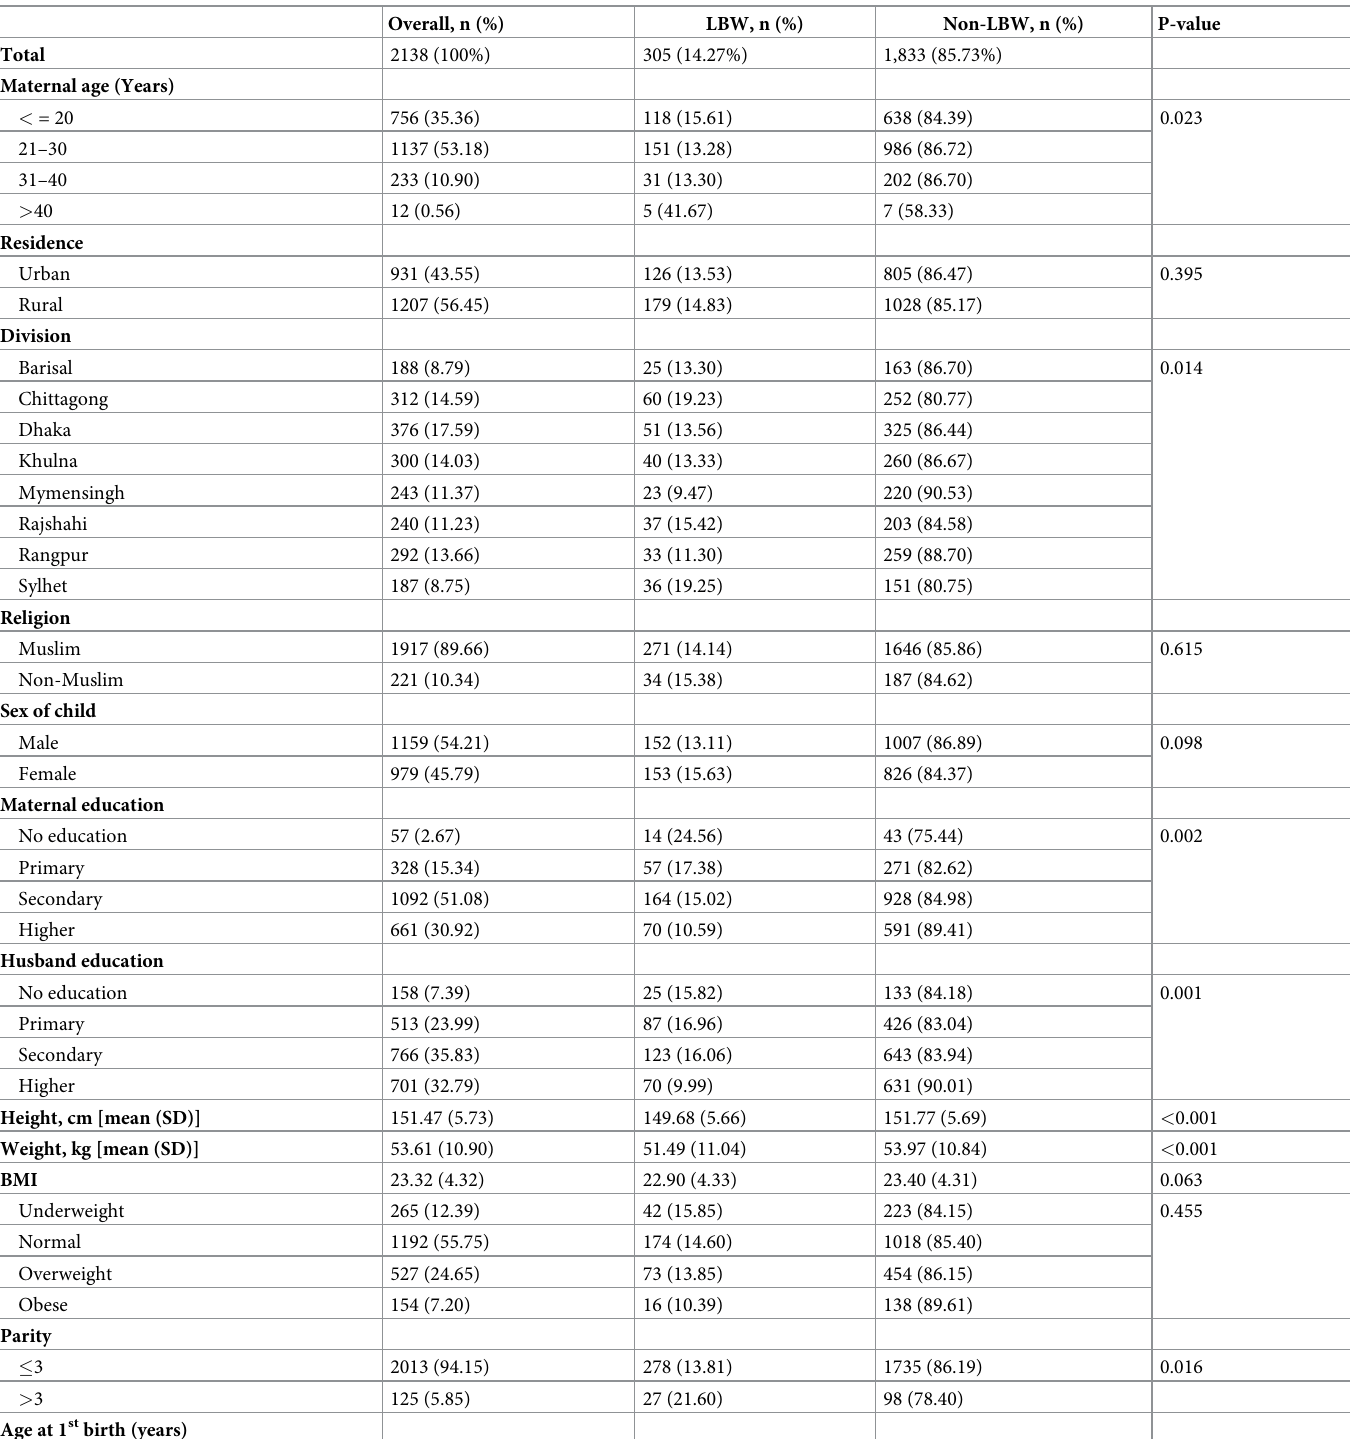
Table 1. Distribution of the risk factors by LBW using BDHS,